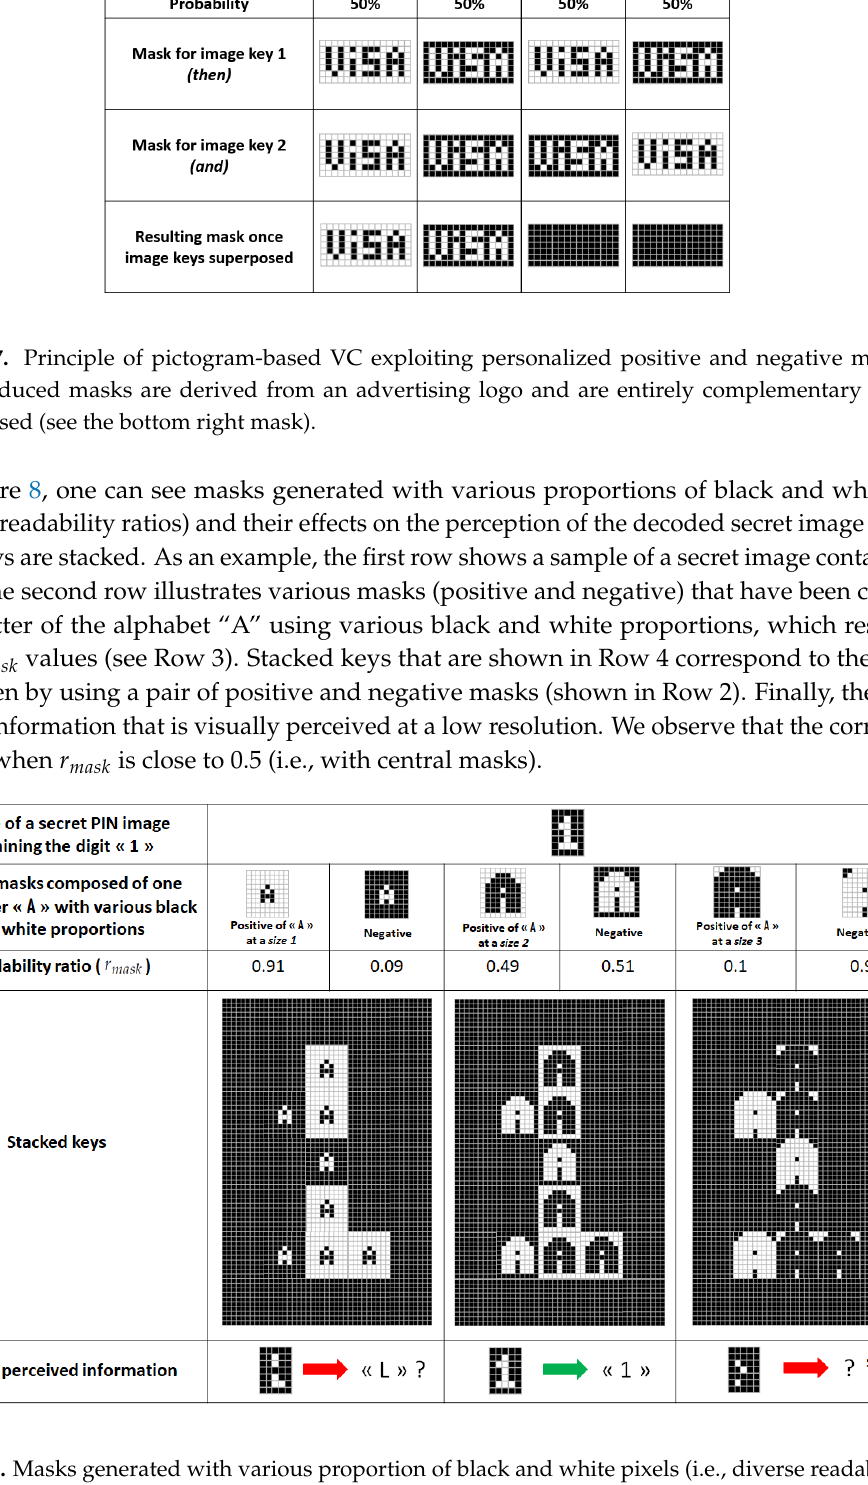
Figure 8. Masks generated with various proportion of black and white pixels (i.e., diverse readability ratios) and their effects on the perception of the decoded secret image when the resulting keys are